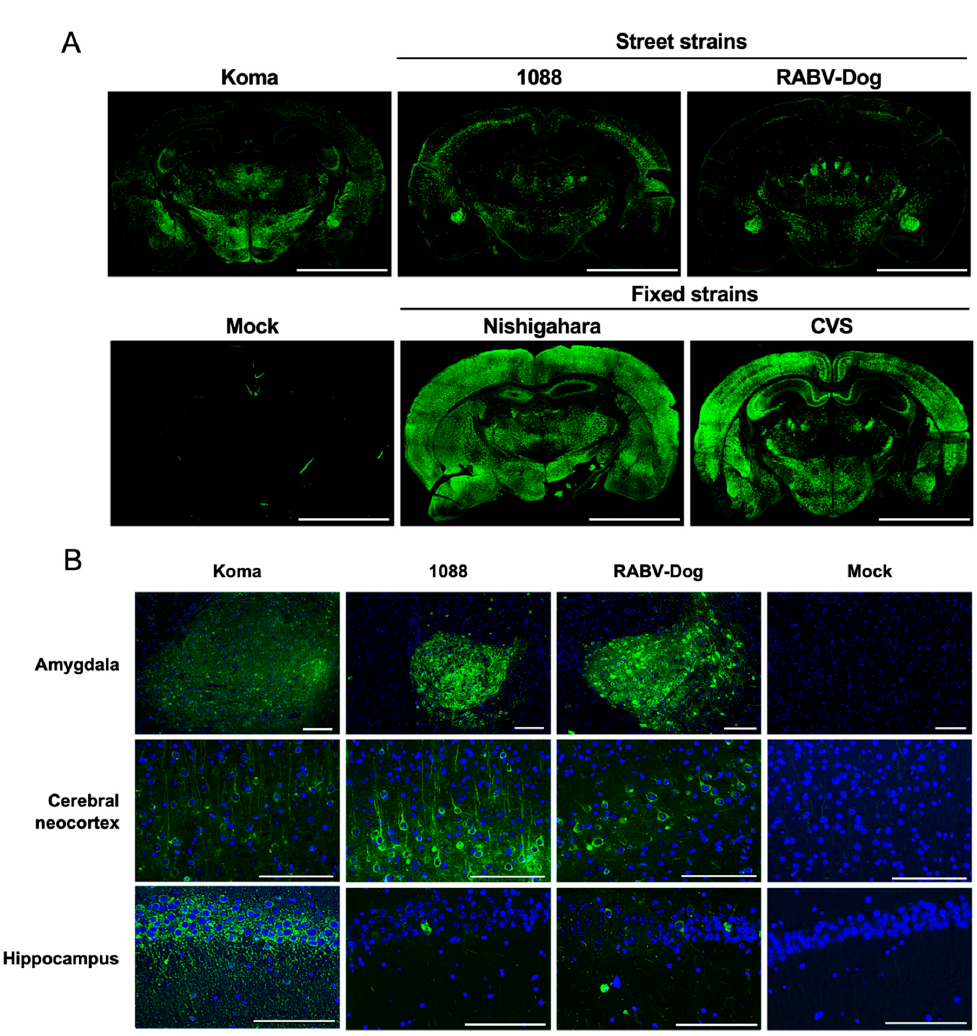
Figure 8. Distribution of viral antigens in the brains of mice infected with the virus strains. The brains were collected from mice infected with each virus strain at the terminal stage of infection. A mock-infected brain was collected at 35 dpi. The brain tissues were stained with an anti-RABV P protein antibody. ( A ) Representative immunofluorescence staining image of RABV P protein (green) in the whole brains of infected mice. The scale bars correspond to 3.5 mm. ( B ) Magnified fields of the amygdala, cerebral neocortex, and hippocampus in mice infected with Koma, 1088, RABV-Dog, or Mock. Nuclei were stained with DAPI (blue). The scale bars correspond to 150 μ m.